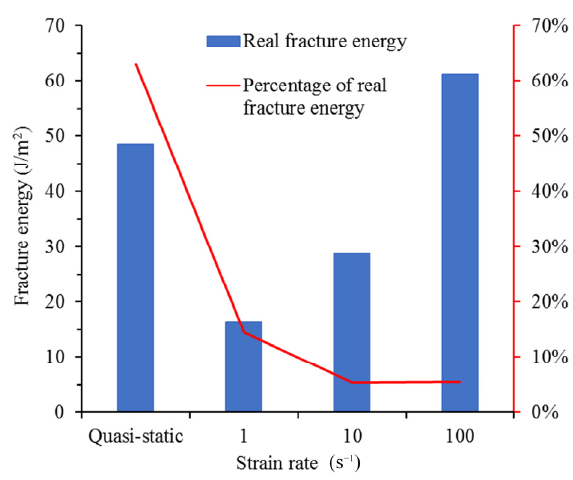
Figure 10. Real fracture energy of concrete under different strain rates.